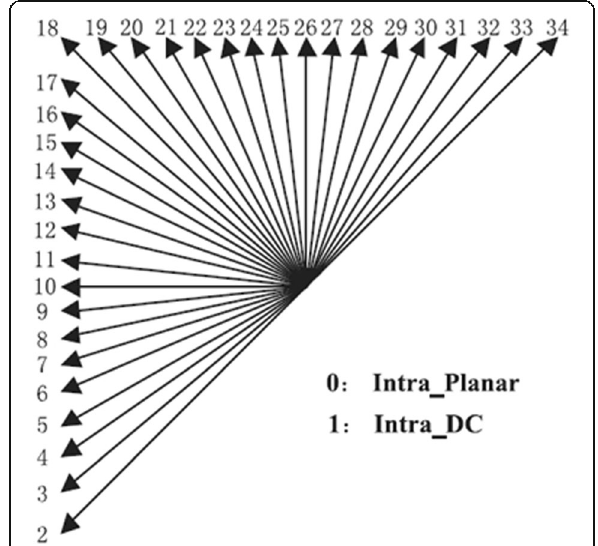
Fig. 2 Intra-prediction modes of